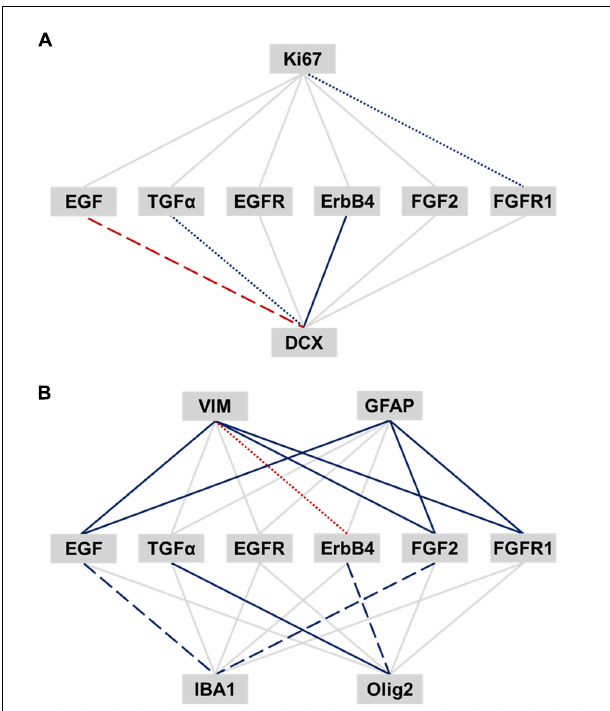
FIGURE 5 | Relationship of EGF- and FGF-related transcripts to expression of adult neurogenesis and gliogenesis markers in the human SEZ. Pearson’s product-moment and semi-partial correlations were performed between EGF- and FGF-related transcripts and markers of adult neurogenesis (A) and gliogenesis (B) . The significance was adjusted by the Benjamini-Hochberg method for false discovery rate correction and set to an α level of p ≤ 0.018. Significance levels are displayed by differently dashed lines ( p > 0.018: gray solid line; p < 0.018: colored round dot line; p < 0.0036: colored dashed line; p < 0.00036: colored solid line). Red lines represent negative correlation, and blue lines positive